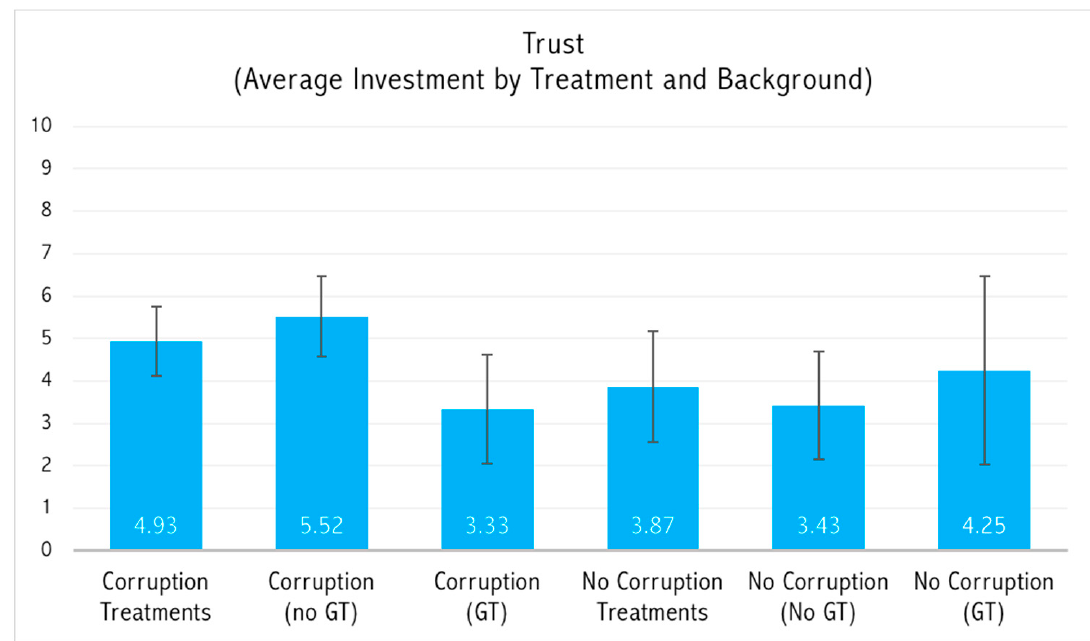
Figure 4. Mean amount sent by the trustor, by treatment and subjects’ background.